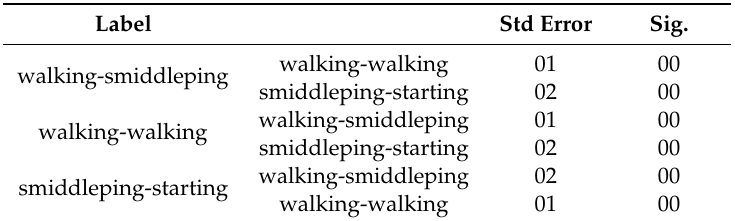
Table 10. Post-hoc comparison table.